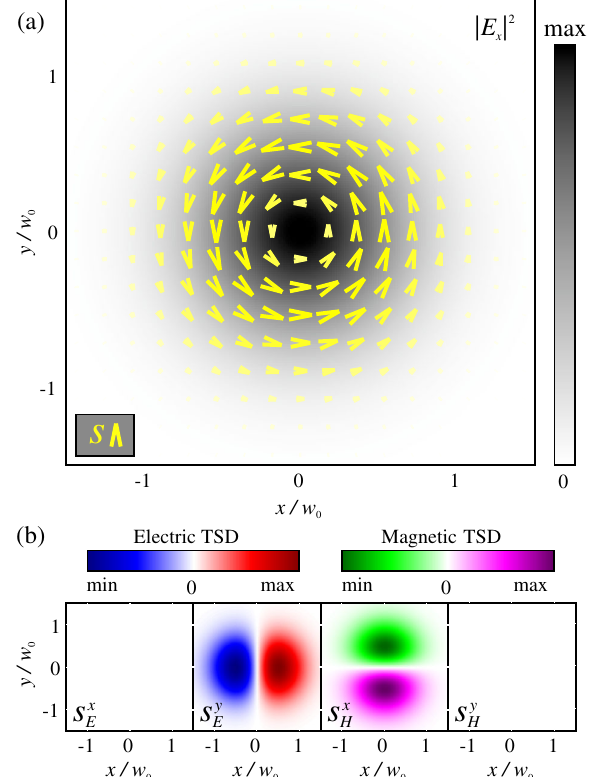
FIG. 1. TSD of a linearly polarized Gaussian beam. Panel (a) depicts the energy density w and the spin density s (yellow arrowheads). Panel (b) illustrates the transverse x and y compo- nents of s E and s H .